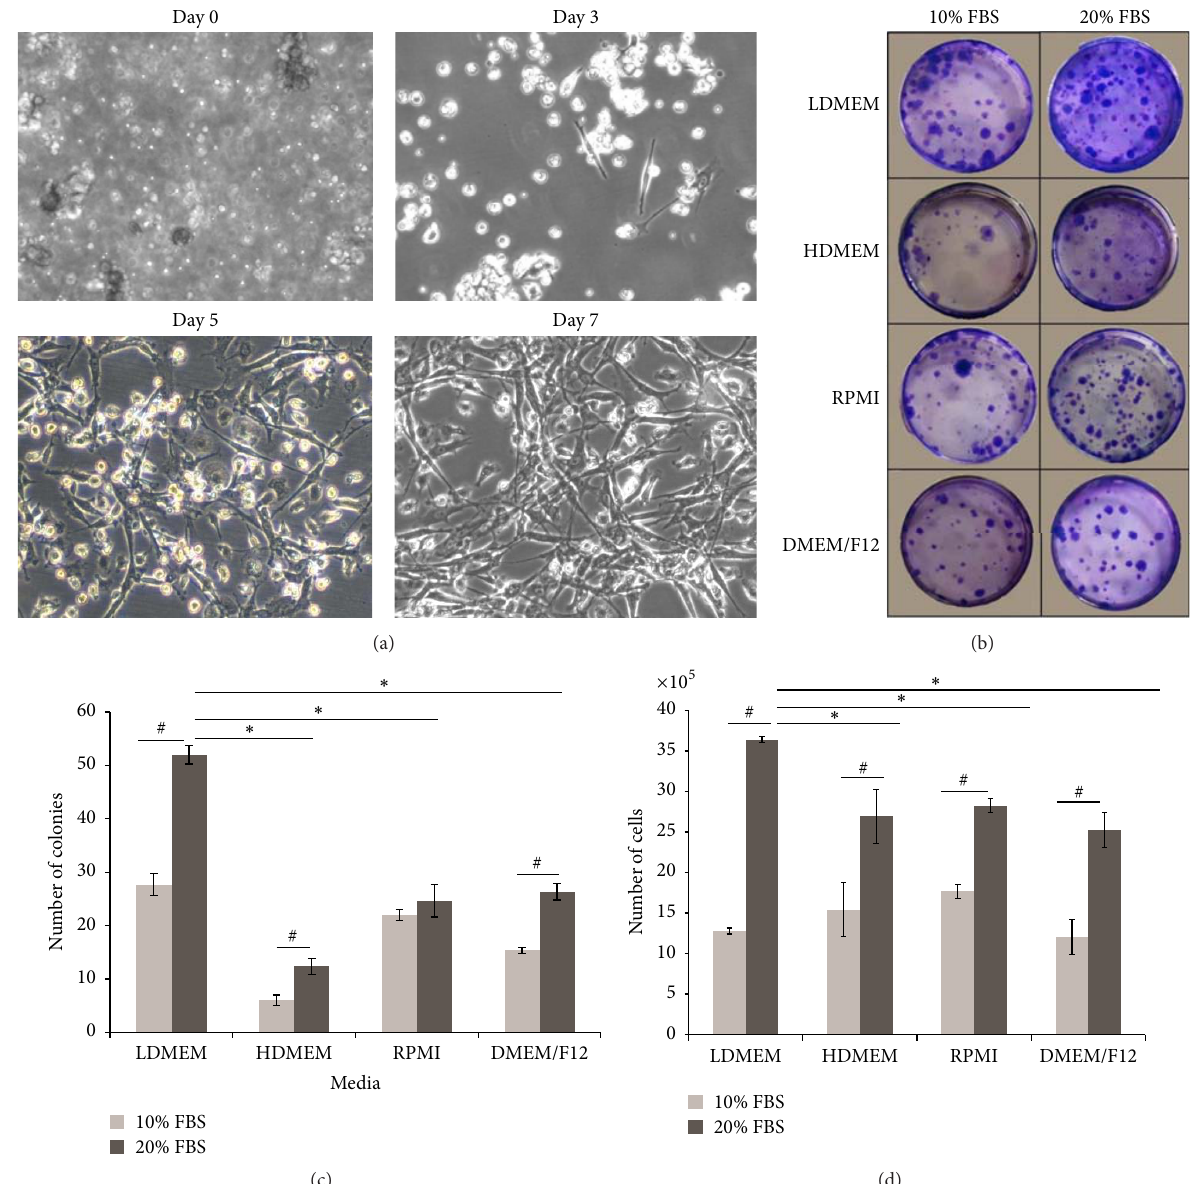
Figure 1: Generation and optimization of rBM-MSCs culture. Bone marrow was harvested from femur and tibia of SD rats and nucleated cells were cultured in T25 flask in day 0. By day 3, cells began to attach and heterogeneous population with predominant fibroblast-like morphology were observed by day 7 (a). One million of nucleated cells from bone marrow were cultured for 10 days in respective media and FBS concentrations. Colonies were subjected to crystal violet staining and colonies which brightly stained were counted (b). Four different basal media with 10% and 20% FBS concentration were utilized to culture 1 × 10 6 freshly isolated BM nucleated cells for CFU and proliferation assays. CFU-f and proliferation assays were measured using crystal violet staining and trypan blue exclusion test, respectively. Results were representative of three independent experiments. ∗ Significant values were compared between LDMEM 20% and other basal media with 20% FBS; # significant values were compared between 10% FBS and 20% FBS of the respective media. 𝑝 ≤ 0.05 . Microscopic magnification: 200x.